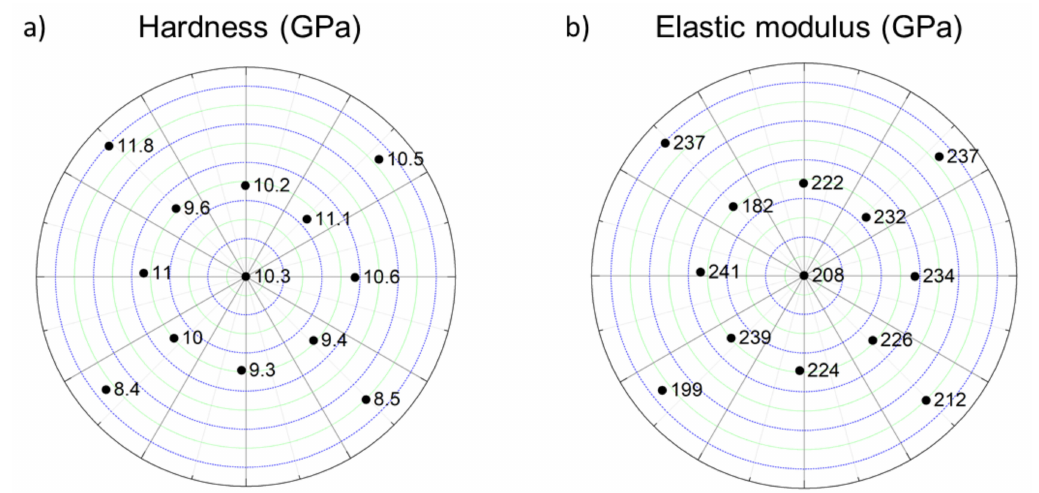
Figure 12. The hardness ( a ) and the elastic modulus ( b ) determined at different points on the Co-Cr-Ni-Fe